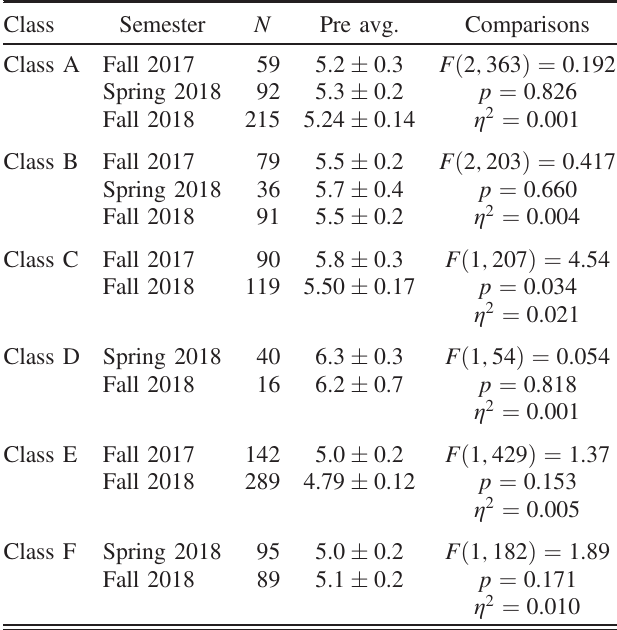
TABLE VII. Summary of test-retest results comparing presur- veys from multiple semesters of the same